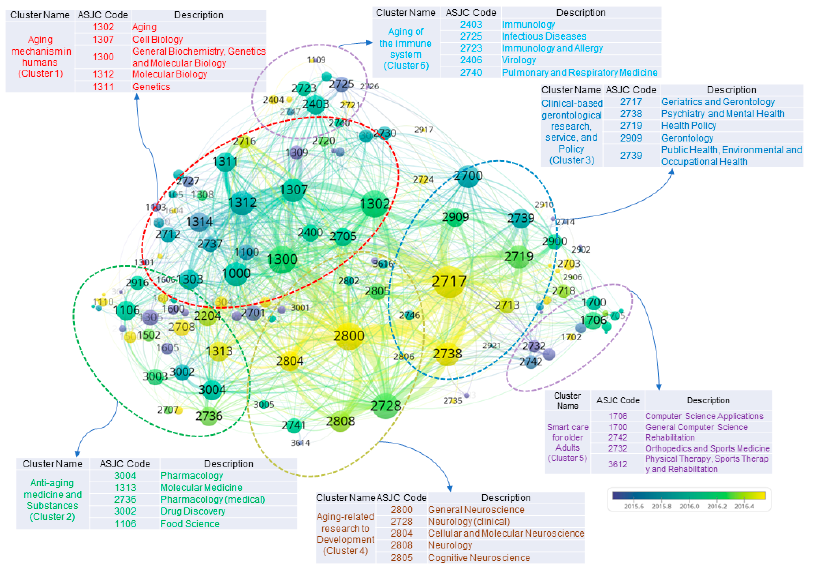
Figure 5. The interdisciplinary trend of changes in the aging-related research fields by period.